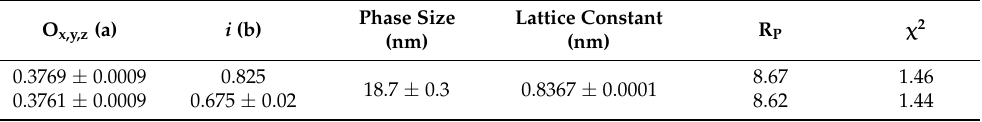
Table 1. Parameters obtained by Rietveld analysis of calcined Mg 0.75 Ca 0.25 Fe 2 O 4 magnetic nanopar- ticles. Calculated R P and χ 2 parameters, phase sizes, strain and degree of inversion obtained by analysis of X-ray diffraction pattern using Profex